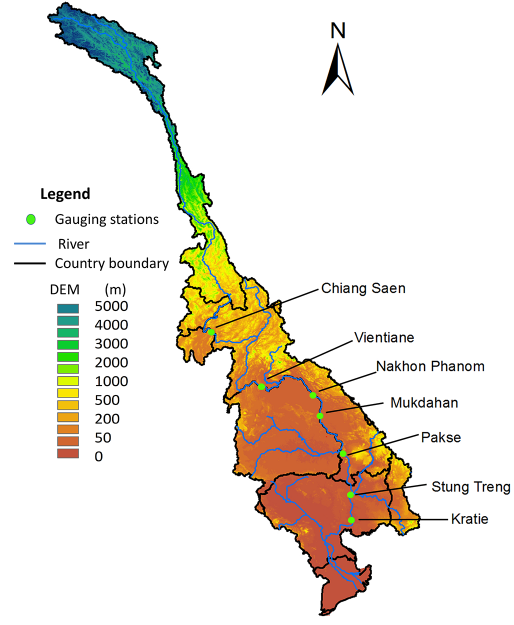
Figure 1. The Mekong River basin’s elevation map and locations of mainstream gauging